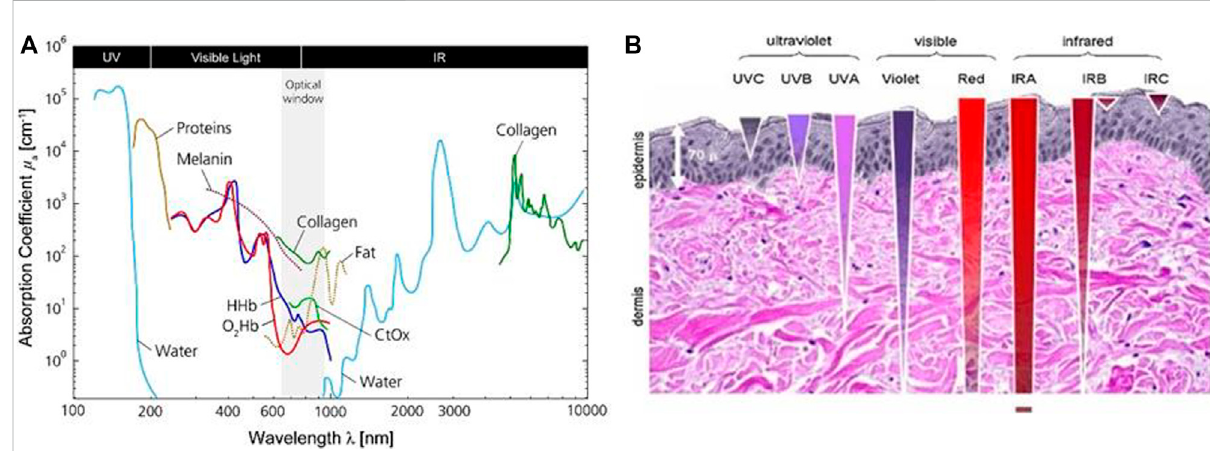
FIGURE 3 (A) Absorption spectra of different endogenous chromophores present in biological tissue. Reprinted from (Scholkmann et al., 2014), Copyright ® 2014,withpermissionfromElsevier. (B) Illustrativeschemeoflightpropagationthroughthetissue.Reprintedfrom(deAssisetal.,2021c), Copyright ® 2021, with permission from